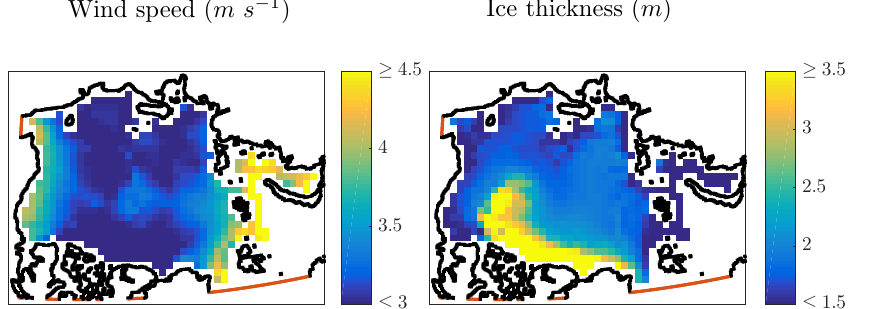
Figure 7. Winter average of wind speed and ice thickness. Both maps are from the neXtSIM simulations, but a similar thickness field and the exact same wind speed field are obtained for the FD